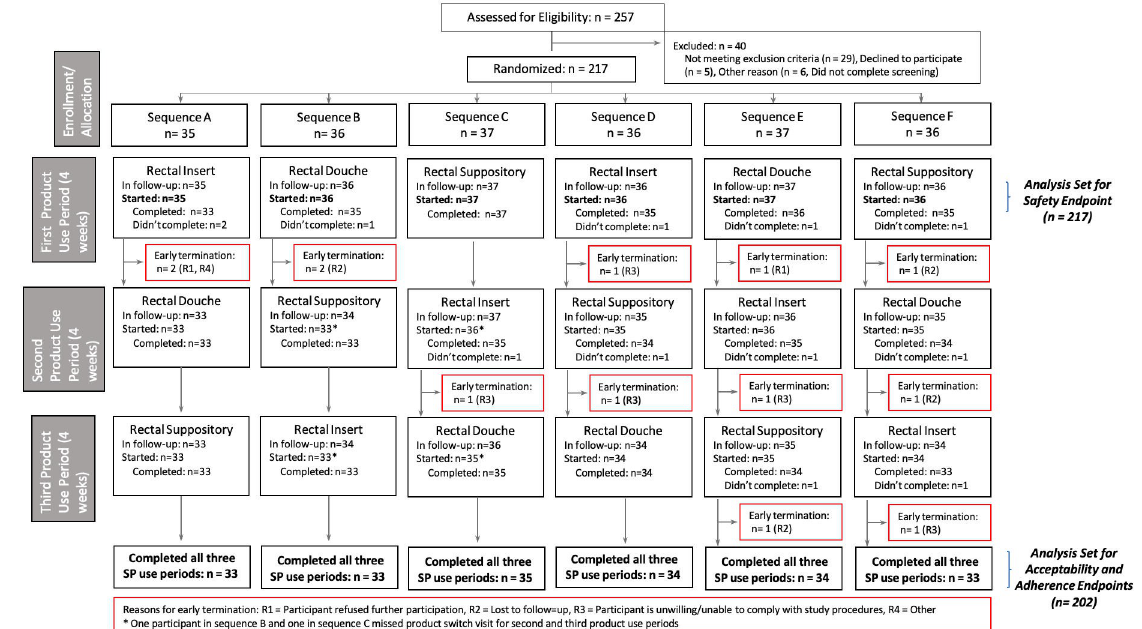
Fig 1. CONSORT disposition of